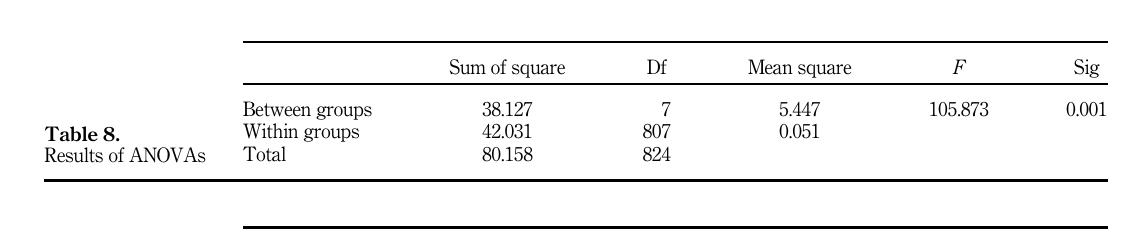
Table 7. Results of ANOVAs between consumer perception and packaging strategies